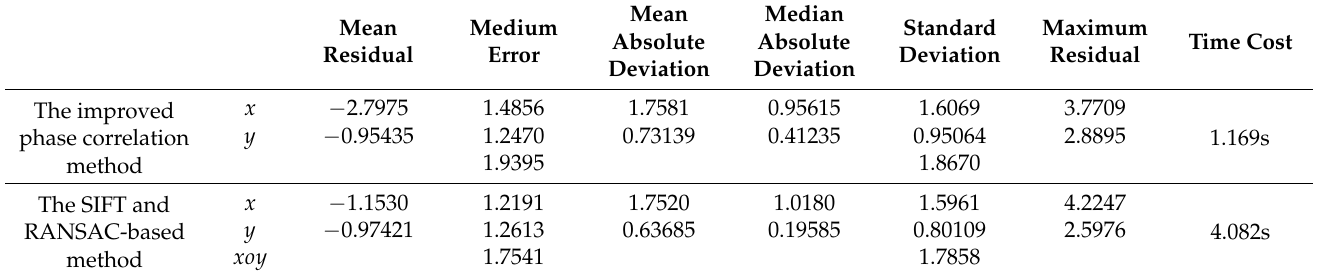
Table 5. The image registration accuracy—river course (units in